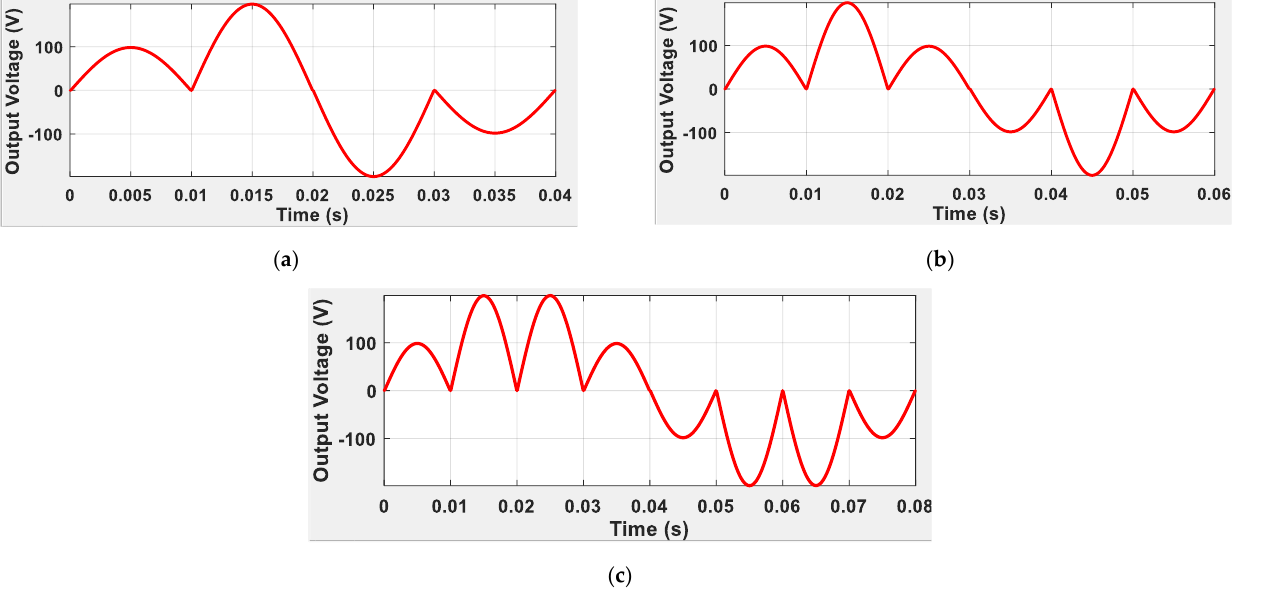
Figure 8. Waveforms of the output voltage with output voltage regulation capabilities for output frequency requirement: ( a ) one-half; ( b ) one-third; and ( c ) one-fourth.